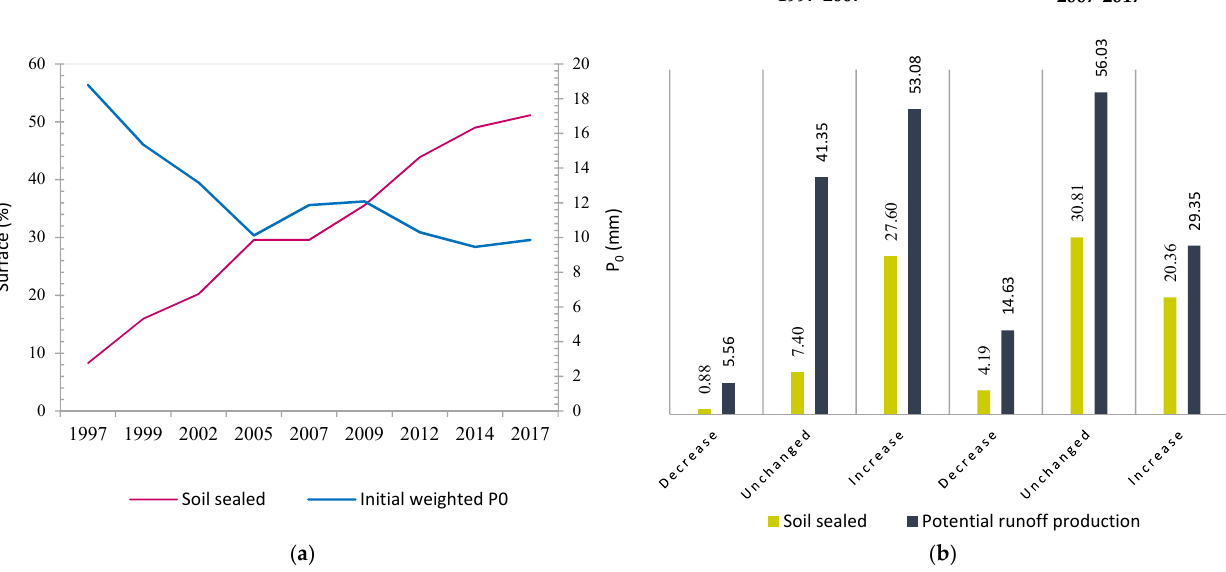
Figure 4. Illustration of ( a ) the evolution of soil sealing and initial weighted P 0 values between 1997 and 2017; ( b ) the percent of surface that experienced changes in soil sealed and P 0 values (a decrease in potential runoff production means an increase in P 0 value, and vice versa).